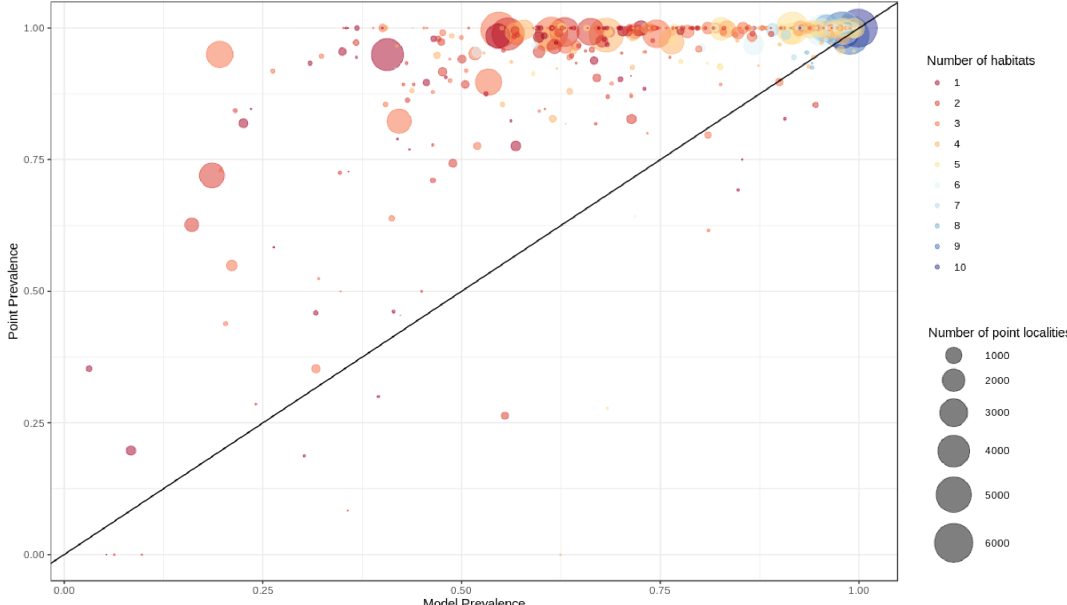
Figure 4. Point prevalence vs. model prevalence for terrestrial mammals. Interpretation as in Fig. 3.